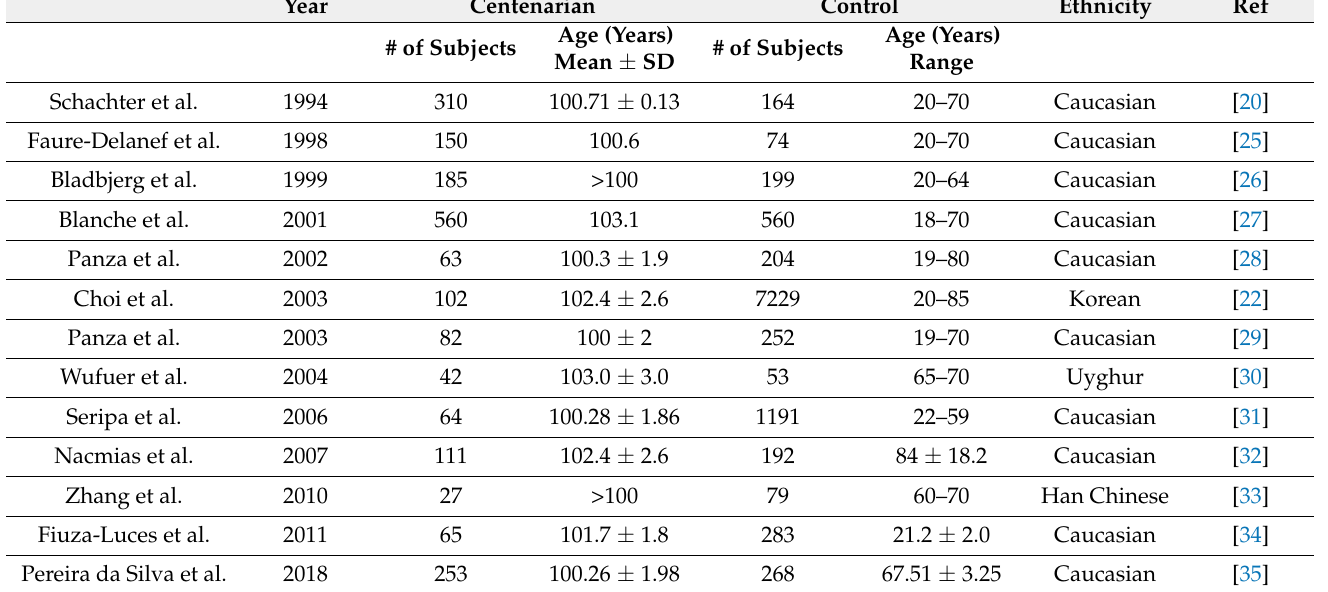
Table 1. Characteristics of studies on ACE I/D polymorphisms in centenarians. A total of 13 studies were included that looked at the frequency of different ACE I/D polymorphisms in centenarians.